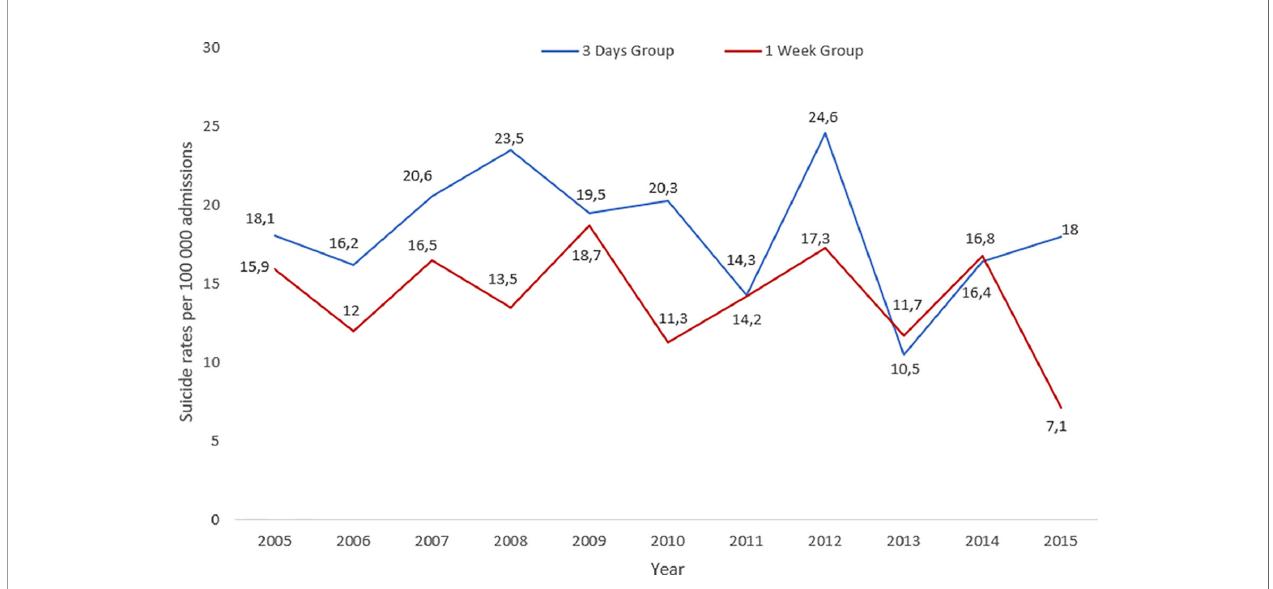
FIGURE 2 | Rates of suicide per 100,000 admissions to psychiatric in-patient care per year in England and Wales between 1st January 1997 until 31st December 2015 for 3 d and 1 week